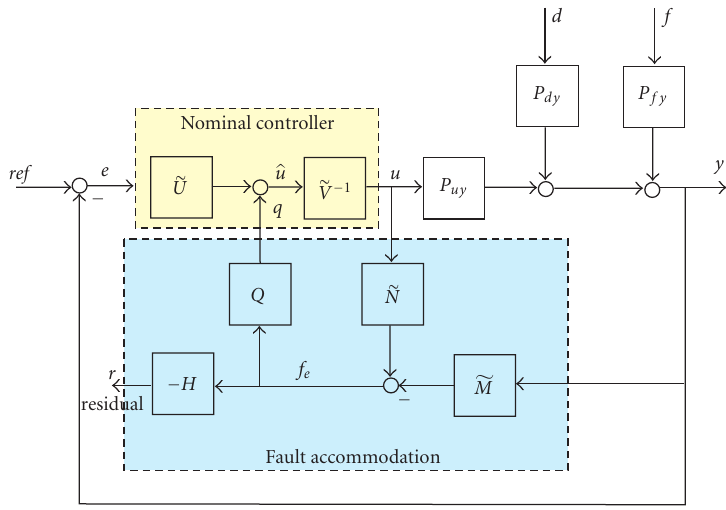
Figure 2: GIMC with additive perturbations and